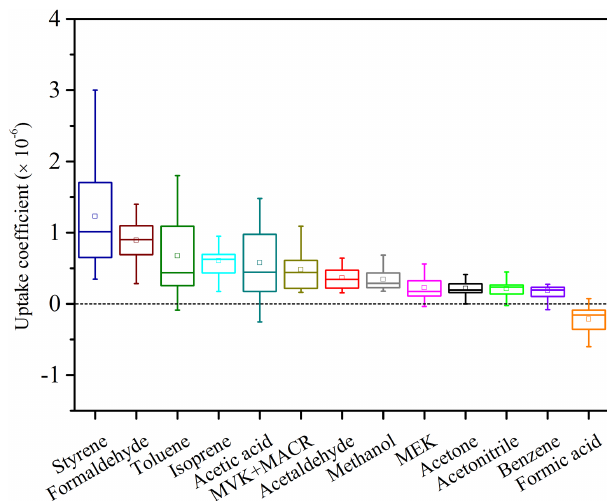
Figure 7. Box-and-whisker plots of the uptake coefficients of mea- sured VOC species, based on daily averaged data. The 25th, 50th and 75th percentiles and minimum and maximum are indicated by bars, and mean values by